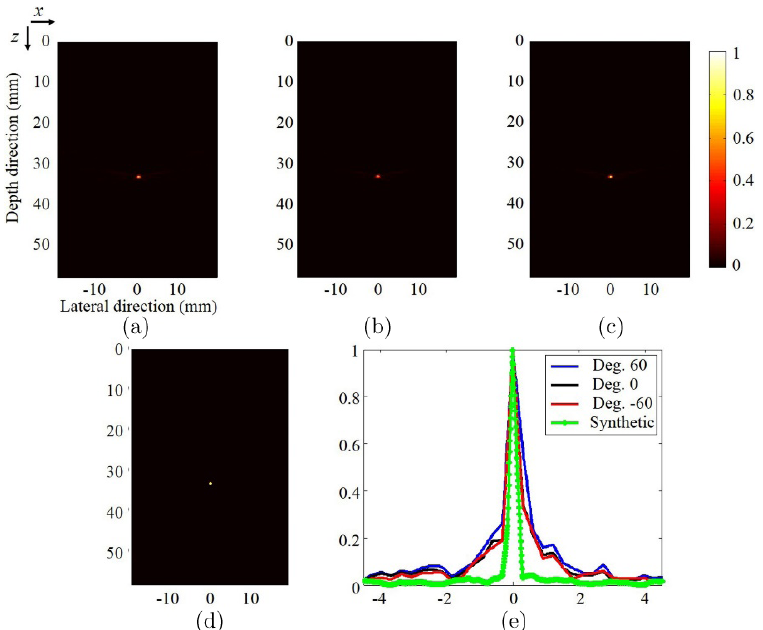
Fig. 7. Synthetic aperture PAT system calibration and enhanced resolution results. (a) – (c) PA images of the rotated phantom at the orientations of (cid:2) 60 (cid:1) , 0 (cid:1) , and 60 (cid:1) , respectively. (d) PA image reconstructed by the synthetic aperture. (e) Lateral pro¯les of the normalized PA intensity along the point target.